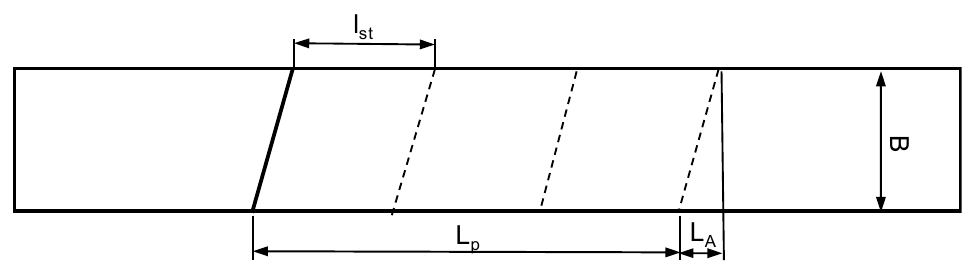
Figure 14. The shape and the dimensions of the tested splices: lst—length of the splice step; 250 mm, L p —splice length, 750 mm; L A —bias length, 0.3 ∙ B = 210 mm; B—belt width, 700 mm. The measured splice strength values are presented in Table 7. The obtained splice strength was compared against the strength required as per PN/C-94147 [31] and against the nominal strength of the spliced belts (which was 1000 kN/m). In the case when different belts were spliced, a comparison was also made with the strength of the splice in the same belt. The values presented in the table, in the cells where the rows representing splices of different belts (1-2, 1-3, 2-3) cross with the columns representing splices of identical belts (1-1, 2-2, 3-3), define the relationship (expressed as percentage) between the strength measured for splices of different belts and the strength measured for splices of identical belts (assumed as 100%). Table 7. Values of longitudinal elasticity moduli for the belt cores in various load ranges. Splice Strength vs. the Strength Splice Strength vs. the Splice Symbol Mean Splice Splice Strength vs. Recorded for Splices of Identical Nominal Belt Strength, (Numbers of Rupture Strength, the Required Value, Belts, [%] Spliced Belts) [kN/m] [%] 670